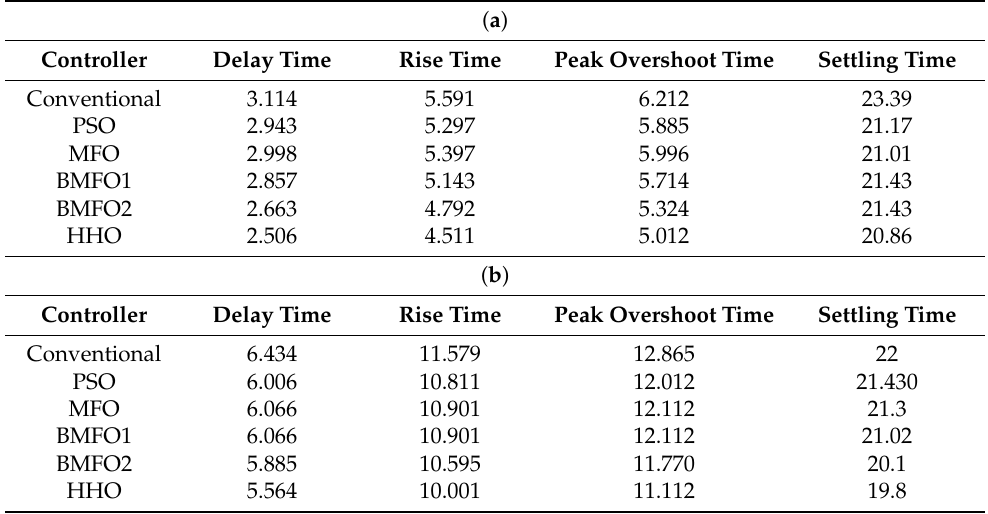
Table 20. ( a ). Graph analysis of GENCOs to DISCOs generation response of Area2 with various controllers under contract violation case. ( b ). Graph analysis of DISCOs to GENCOs generation response of Area2 with various controllers under contract violation